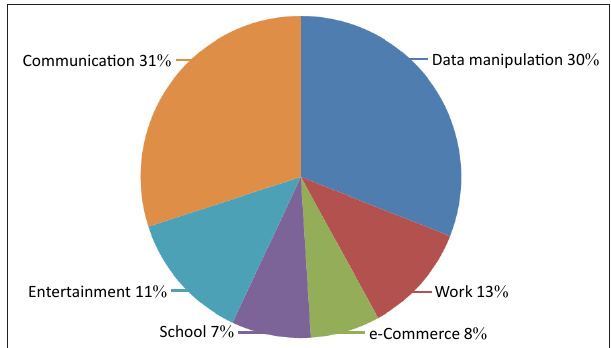
FIGURE 1: Uses of information and communication technology (ICTs).